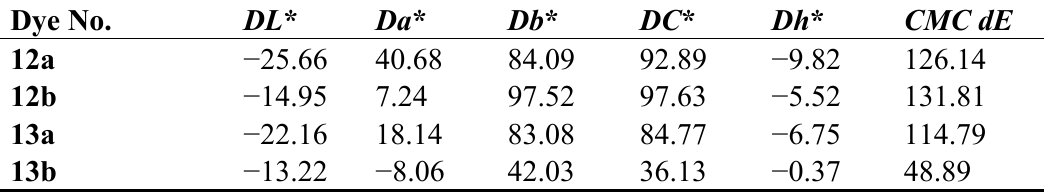
Table 1. Optical measurements of the synthesized dyes on the polyester fabrics.